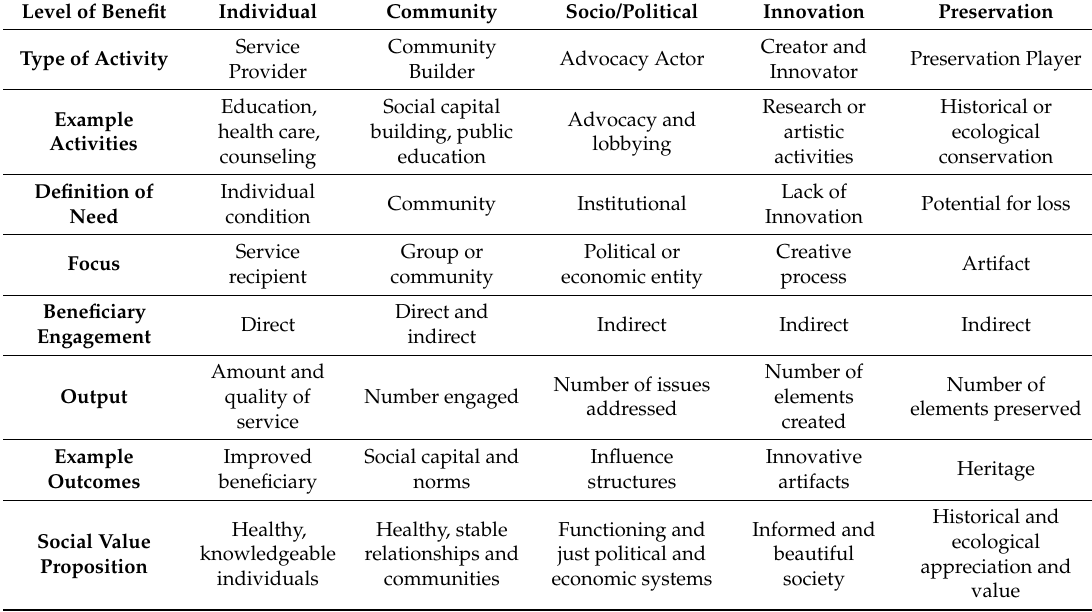
Table 1. Classification of Program